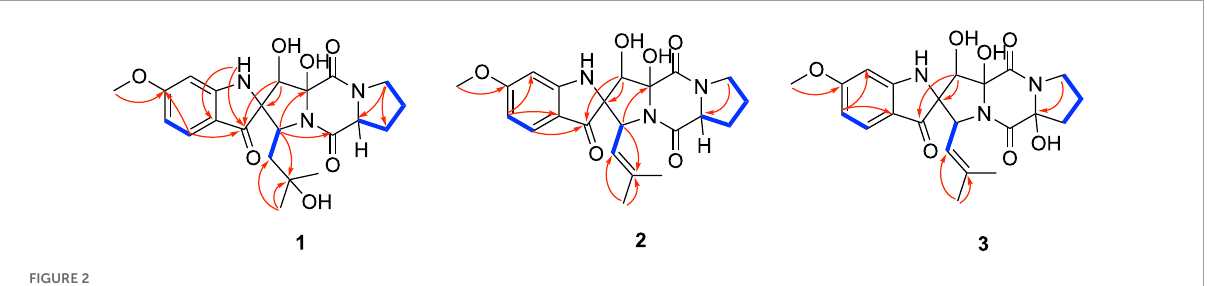
FIGURE2 Key HMBC and COSY correlations of compounds 1–3.